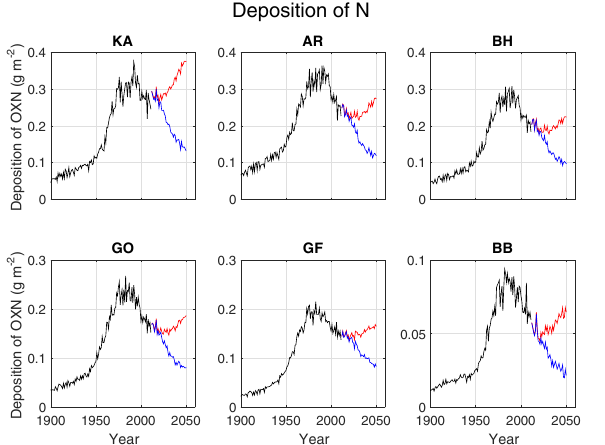
Figure 9. Annual deposition of nitrogen from all emission sources (gm − 2 ) in six basins of the Baltic Sea (defined in Fig. 2), for the years 1900 to 2050. The red line corresponds with shipping scenar- ios 1 to 3 and the black line shows historical shipping (derived in Omstedt et al., 2015).